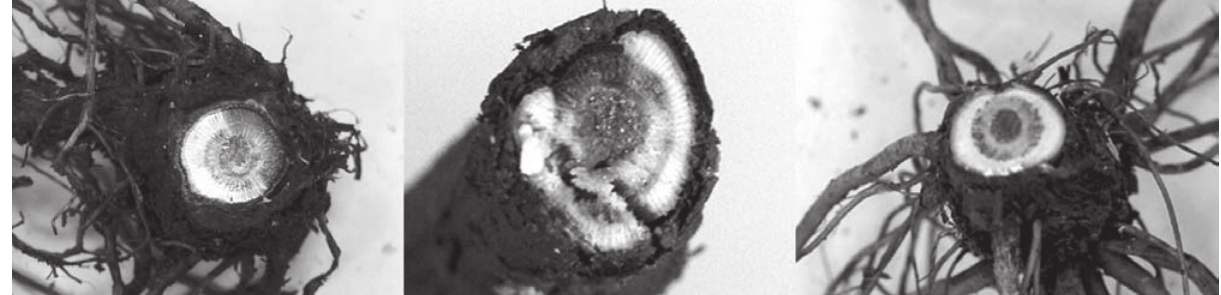
Fig. 1. Symptoms of vascular streaking and xylem necrosis are commonly observed in vines infected with Cylindro- carpon spp.